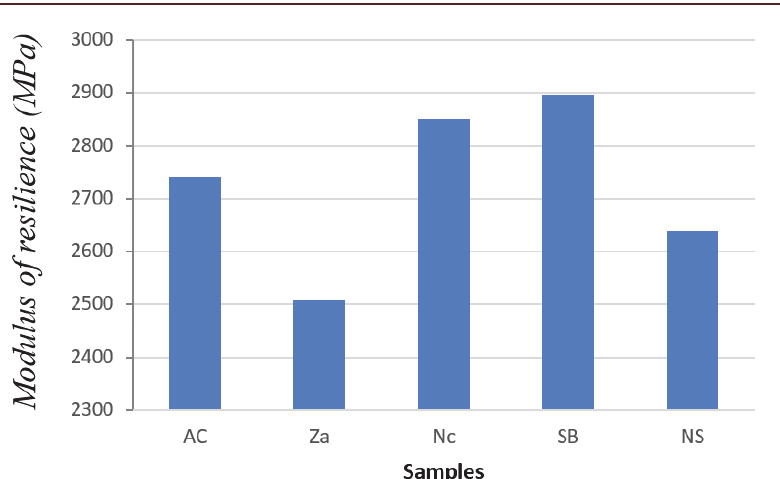
Figure 3: Results of modulus of resilience for modified and non-modified specimens